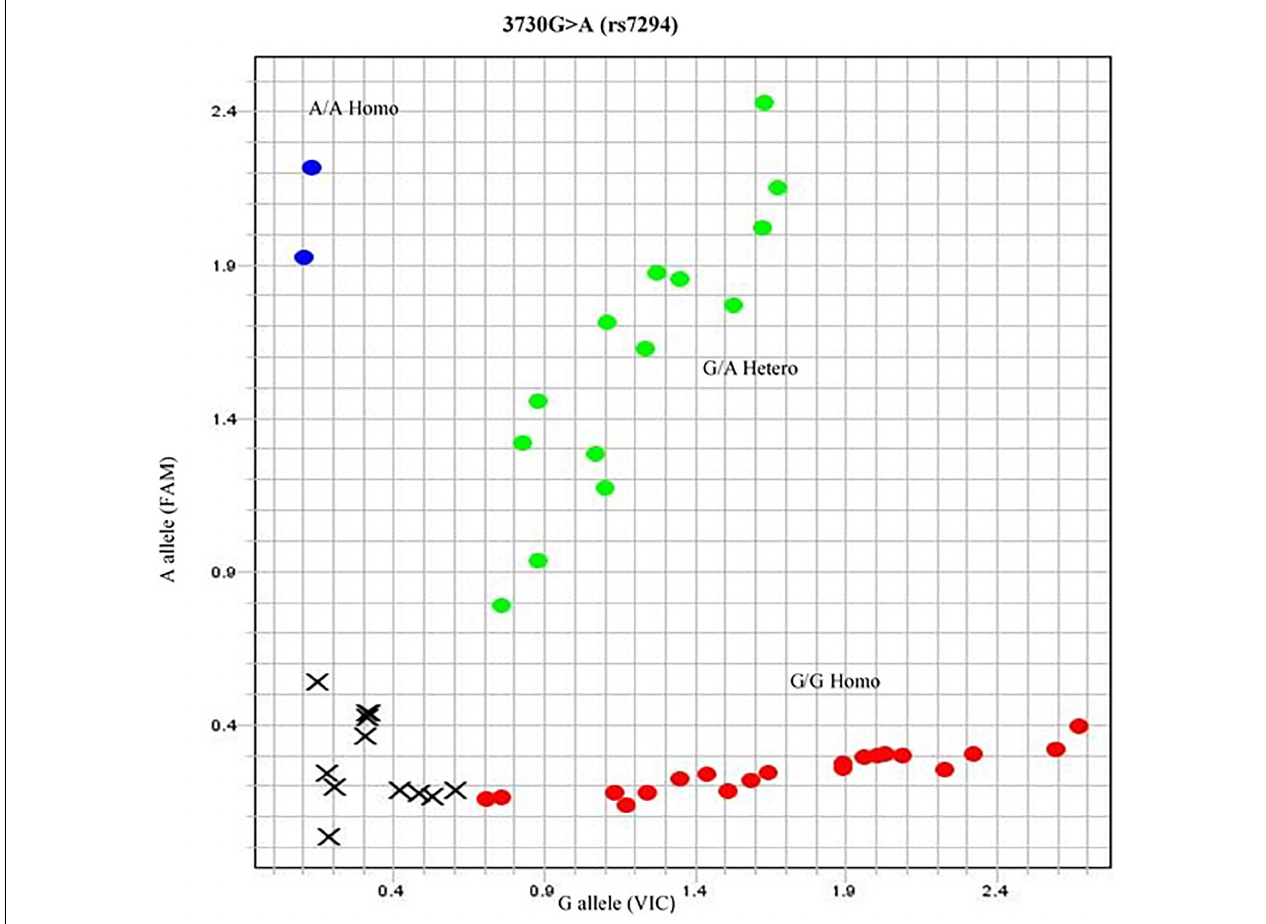
FIGURE 3 | Allelogram showing 3730G > A (rs7294) SNP. The SNP represented in red dotted area as homozygous GG phenotype obtained by TaqMan SNP genotyping assay. The genotype of samples of rs7294 was further confirmed by direct sequencing.